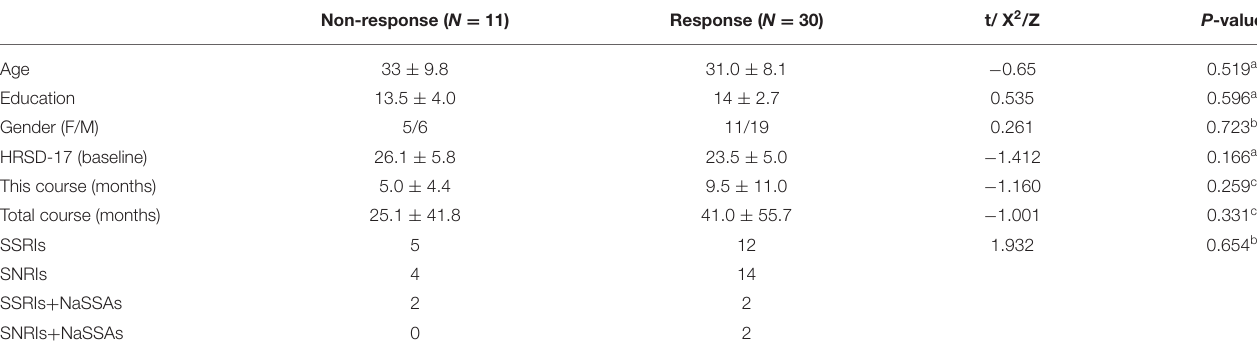
TABLE 2 | Participant demographics.